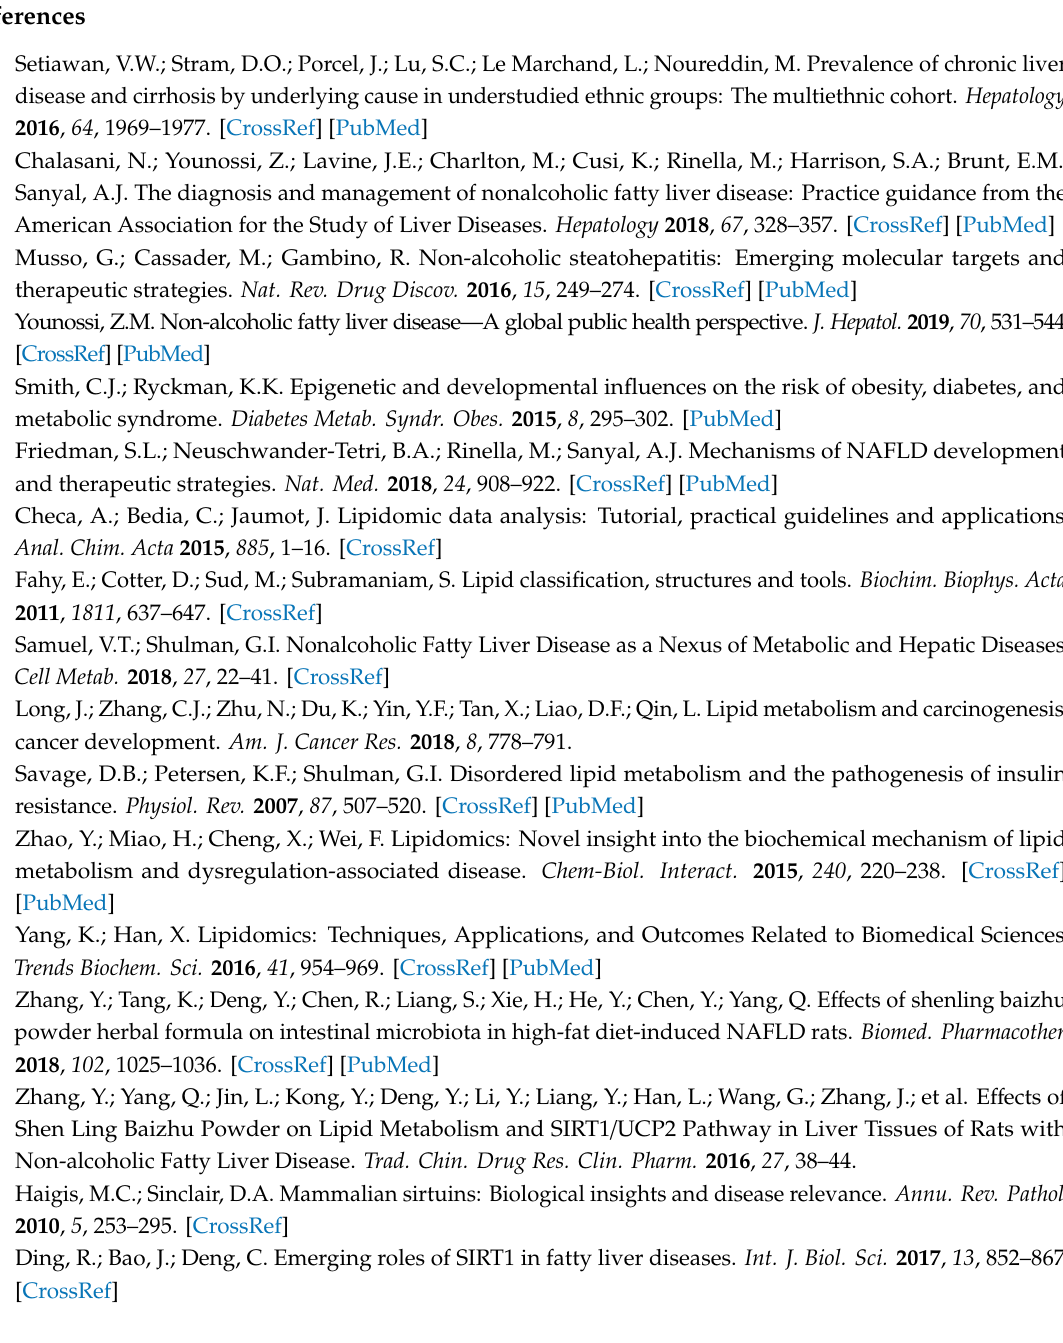
Metabolic networks of di ff erential lipid species visualized in Cytoscape; Table S1: Detailed information of Shenling Baizhu San; Table S2: Di ff erential lipid species in HFD group relative to NC group; Table S3: Di ff erential lipid species in HFD + SL group relative to HFD group; Table S4: Di ff erential lipid species in HFD + EX + SL group relative to HFD